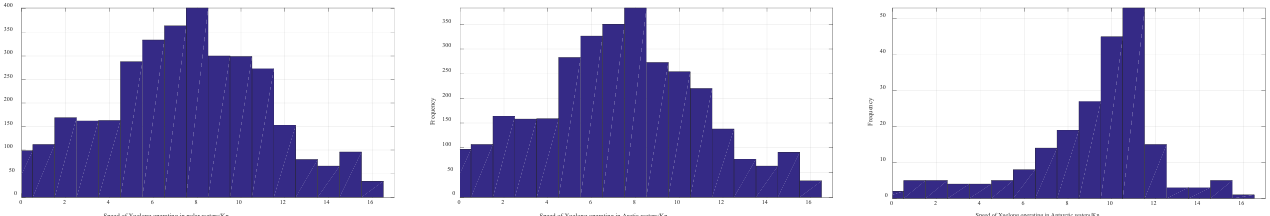
Figure 3. The speed distribution of the ship movement in polar waters. Table 1. Statistics of ship speeds in polar waters